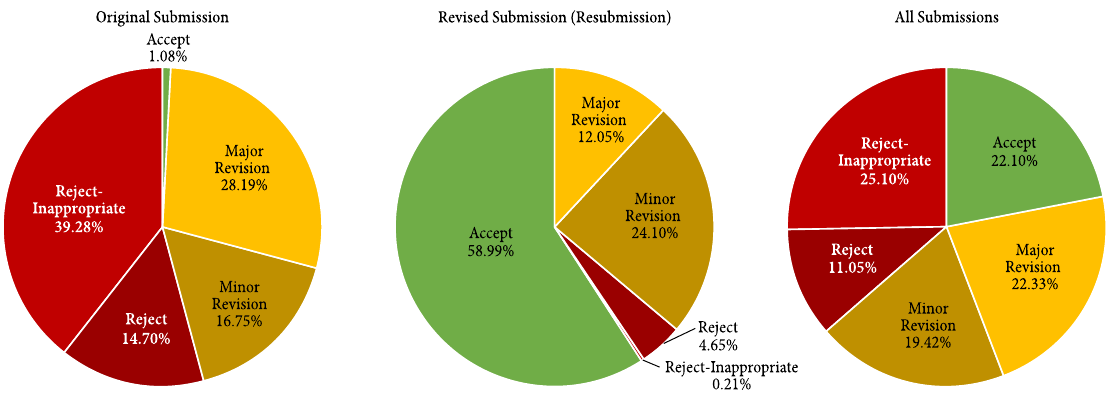
Fig. Decision ratios of submitted manuscripts in